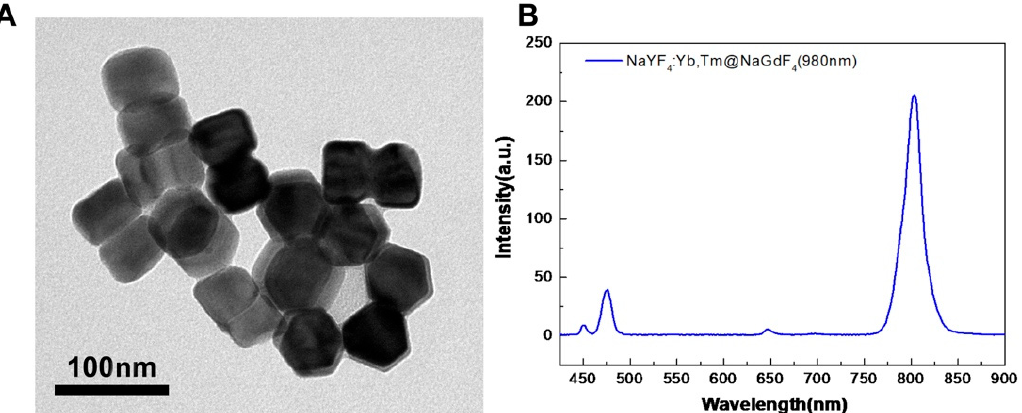
Figure 2. Characterizations of UCNP@SiO 2 -TS (NaYF4:Yb 3+ /Tm 3+ @ NaGdF4 @ SiO 2 -NH2). ( A ) The high-resolution TEM image exhibits a regular hexagonal shape of the particles. ( B ) Luminescence spectrum of UCNP@SiO 2 -TS under 980 nm laser-light excitation. Two peaks can be observed at approximately 470 and 800 nm.